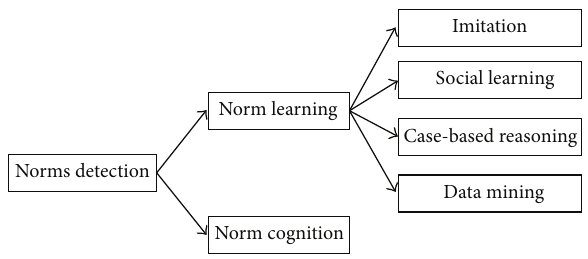
Figure 7: Norms detection approaches and